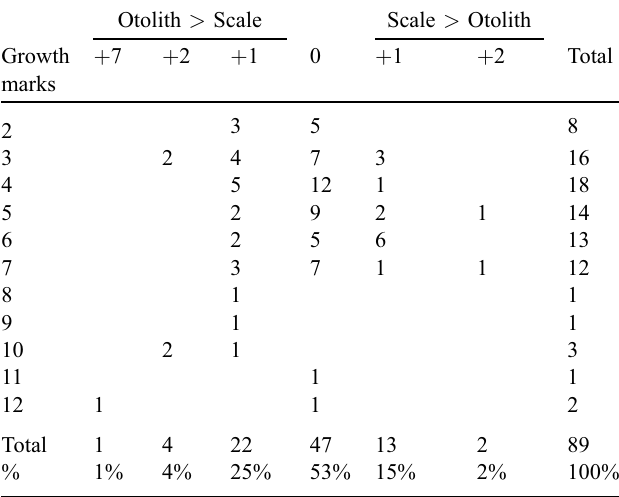
Table 2. Differences between the readings of annual growth marks in otoliths and scales of Pagrus pagrus .